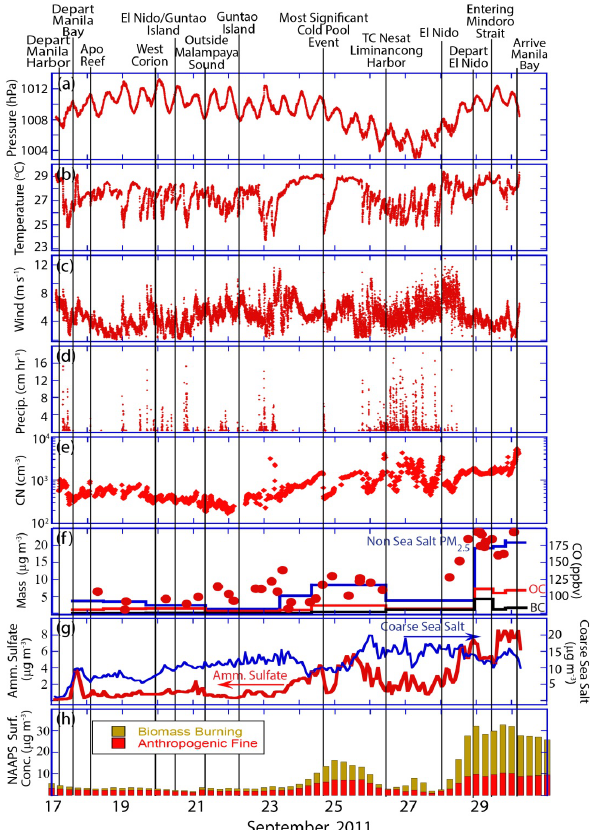
Figure 7. Cruise time series of key meteorological, aerosol and chemistry indicators in 1min intervals. Key sampling points and events are marked by vertical lines. (a) Surface pressure (hPa); (b) ambient air temperature ( ◦ C); (c) wind speed (ms − 1 ); (d) precipita- tion rate (cmh − 1 ); (e) CPC total particle count; (f) left axis: PM 2 . 5 gravimetric mass with sea salt subtracted, and associated organic and black carbon; right axis – dots: can carbon monoxide (ppbv); (g) left axis – red: DRUM impactor time series of inferred PM 1 inferred ammonium sulfate (µgm − 3 ); right axis – blue: inferred coarse mode sea salt ( d p >0.8µm). (h) NAAPS total fine mode par- ticle mass segregated into anthropogenic ( + biogenic) fine mode and biomass